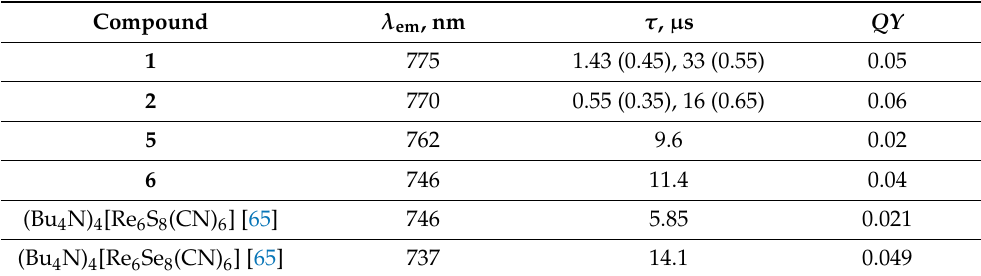
Figure 20. Emission spectra of: ( a ) 1 ( λ em = 775 nm) and 2 ( λ em = 770 nm); ( b ) 5 ( λ em = 762 nm) and 6 ( λ em = 746 nm). Table 1. Spectroscopic and photophysical data of the solid samples of 1 , 2 , 5 and 6 and the parent compounds.